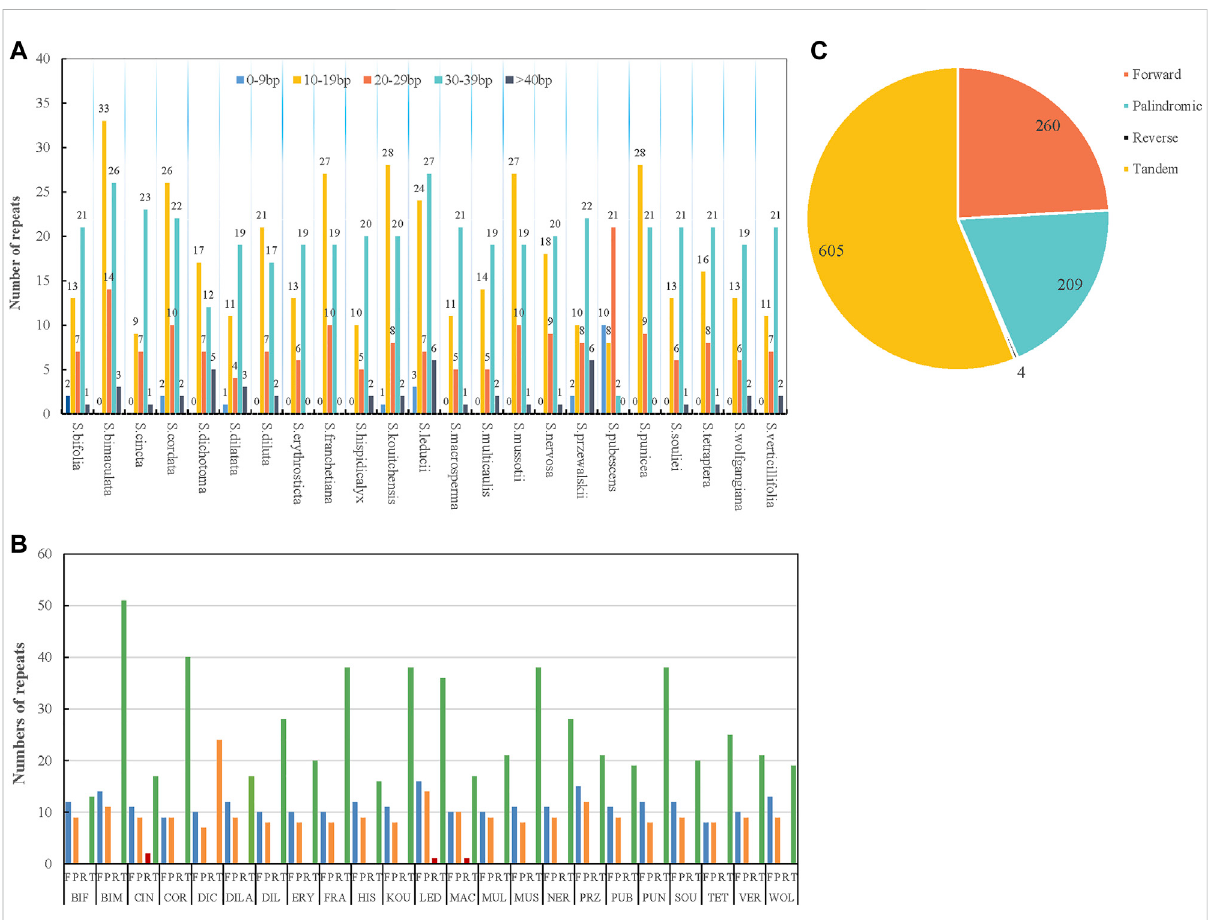
FIGURE 2 Type of repeated sequences in the 23 Swertia L. plastid genomes. (A) Number of repeat sequences by length; (B) number of four repeat types (Note:BIFrepresents S.bifolia ;BIMrepresents S.bimaculata ;CINrepresents S.cincta ;CORrepresents S.cordata ;DICrepresents S.dichotoma ;DILA represents S. dilatata ; DIL represents S. diluta ; ERY represents S. erythrosticta ; FRA represents S. franchetiana ; HIS represents S. hispidicalyx ; KOU represents S. kouitchensis ; LED represents S. leducii ; MAC represents S. macrosperma ; MUL represents S. multicaulis ; MUS represents S. mussotii ; NER represents S. nervosa ; PRZ represents S. przewalskii ; PUB represents S. pubescens ; PUN represents S. punicea ; SOU represents S. souliei ; TET represents S. tetraptera ; VET represents S. verticillifolia ; and WOL represent S. wolfgangiana ); (C) pie chart showing the numbers of four repeat